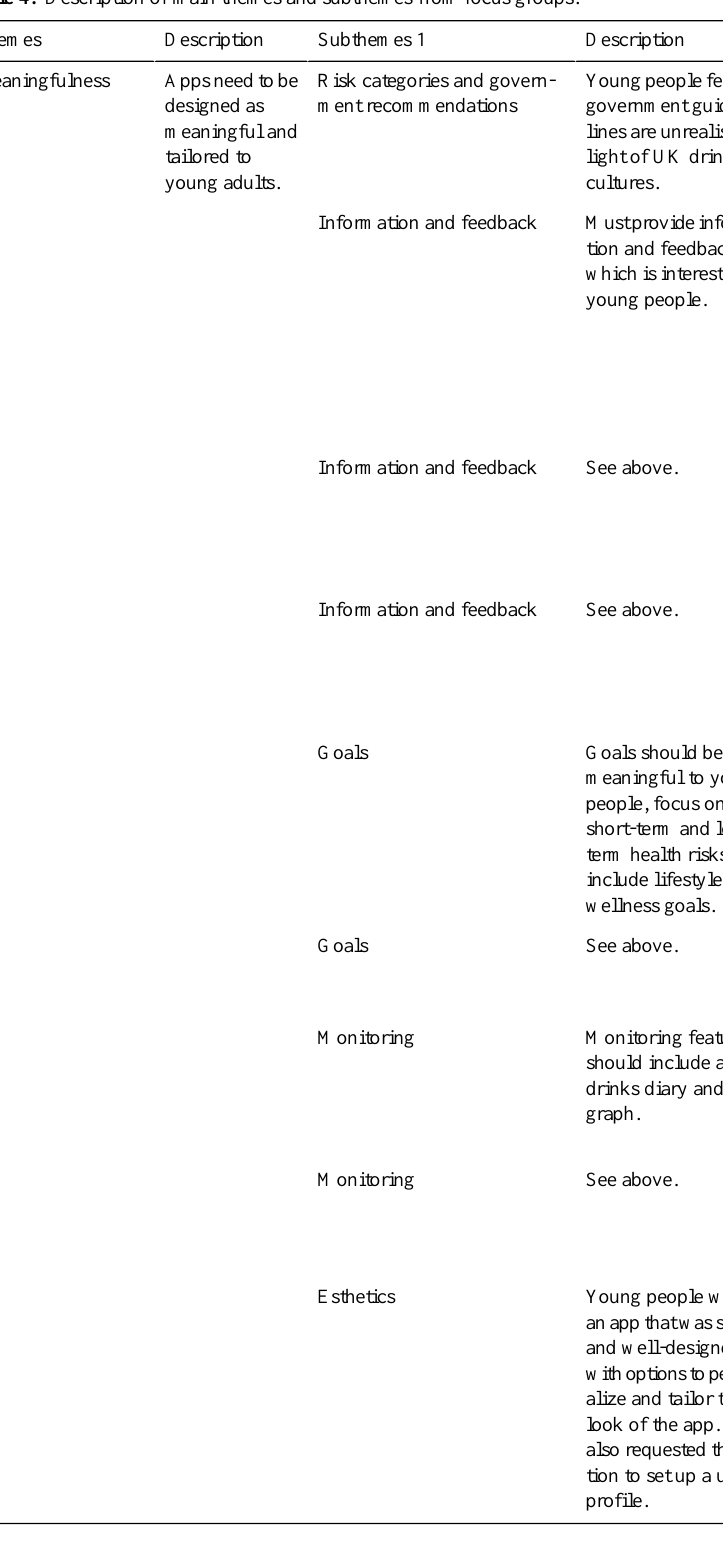
Table 4. Description of main themes and subthemes from focus groups.